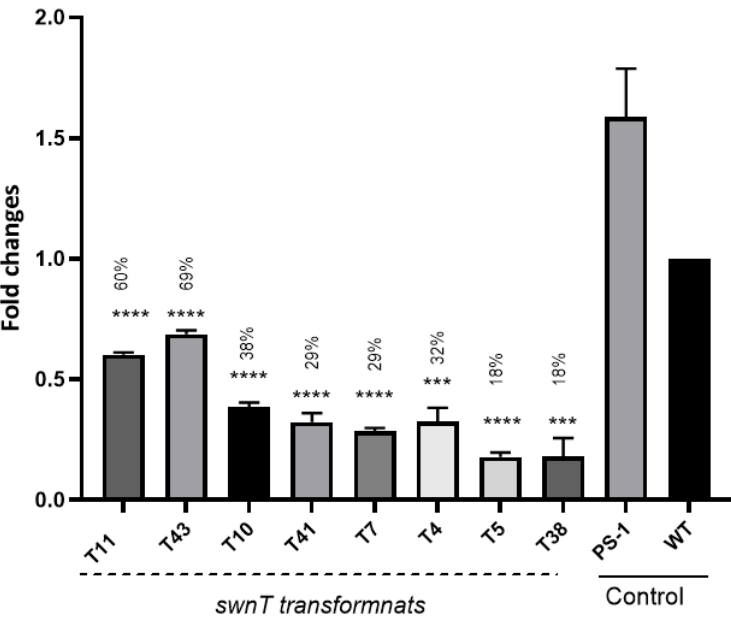
Figure 3. Reverse transcription quantitative PCR (RT-qPCR) analysis of total RNA of WT and swnT- silencing transformants. Target swnT gene expression was normalized to the expression pattern of fungal internal control gene RDN5.8. WT: wild-type S. leguminicola , PS-1: S . leguminicola transformed with empty vector (pSilent-1), pSilent- swnT transformants (T10, T41, T7, T5, T11, T43, T38 & T4) growing on PDA for four days after transformation with the silencing construct pSilent- swnT . Fold change is normalized to WT, and percentages represent percentage of swnT expression relative to WT. Error bars represent the ± SEM ( n = 3), p values are calculated using unpaired Student’s t test compared with WT ( *** p < 0.001, **** p < 0.0001, ns = not significant p > 0.05).